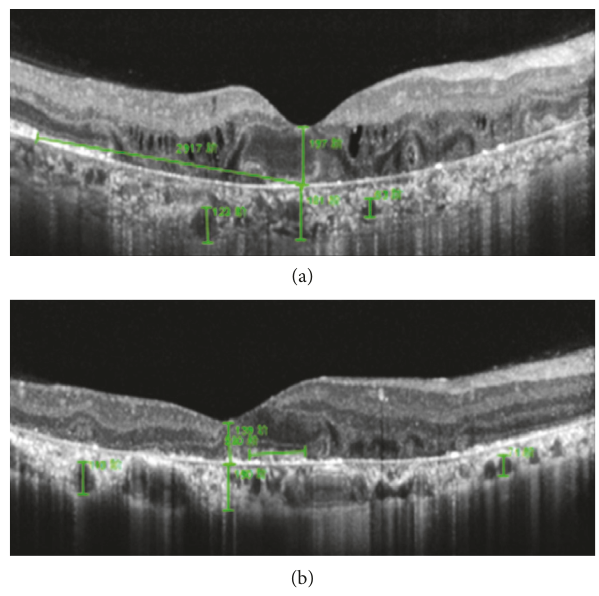
Figure 1: OCT parameter measurement in type 1 patients. (a) Measurement methods of the right eye parameters of P1. (b) Measurement method of parameters of both eyes of P2 and P3, and the left eye of